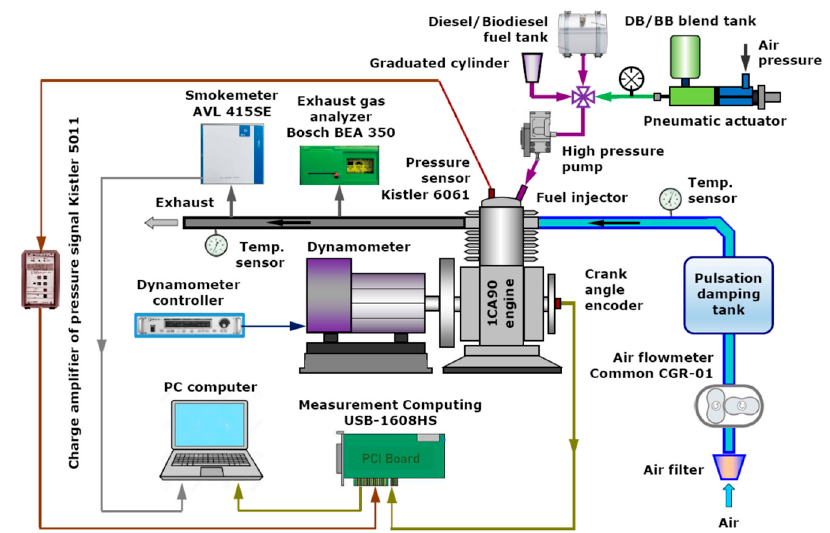
Figure 3. The engine test stand. Table 1. Technical specifications of the test devices.